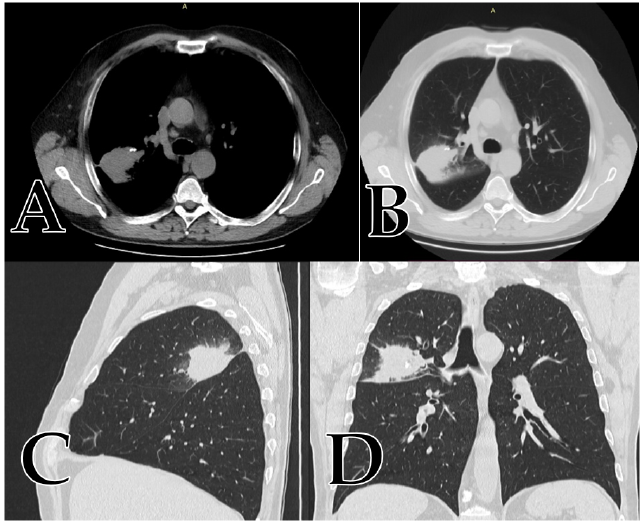
Figure 3. ( A , B ) coronal view; ( C ) sagittal view; ( D ) axial view of a right upper lobe mass presenting all the aspects of malignancy: size over 5 cm, gross spiculation, attenuation alternances (part solid, part GGO), punctuate calcification, no tumoral fatty tissue, positive bronchial sign with a mean value of 34 HU and a growth rate of 5 cm over 6 months